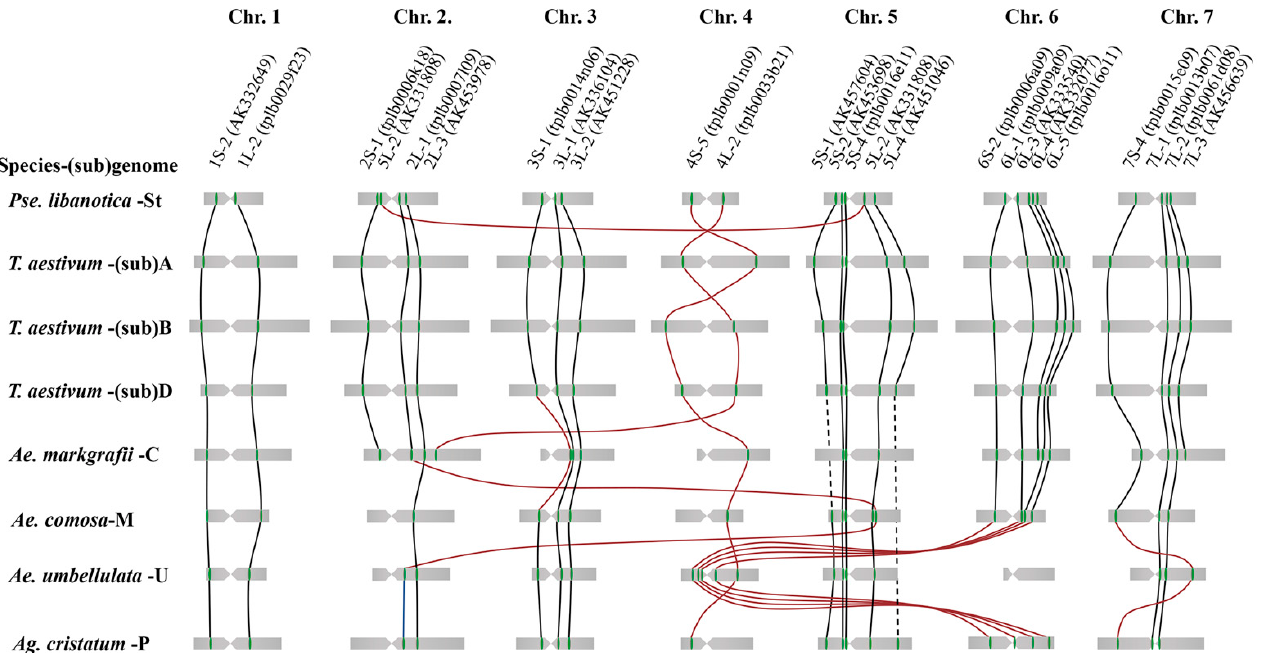
Figure 8. Cross-genome homoeologous within St genome of P. libanotica , A, B, and D sub-genome of T. aestivum , C genome of Ae. markgarii , M genome of Ae. comosa , U genome of Ae. umbellulate , and P genome of Ag. cristatum. Relatively chromosome length and gene position data of A, B, and D sub-genome of T. aestivum were prepared based on Chinese Spring reference genome (RefSeq v2.1) in the WheatOmics website (http://202.194.139.32/blast/blast.html, accessed on 2 November 2022) [35], C genome was generated from the publication of Danilova et al. [18], M, U, and P genomes were referred to by Said et al. [19,20]. The green dot on the chromosome indicates the cDNA sequence, and the red dot is a duplication of the original sequence. Black lines cross-genome indicate the collinearity and red lines present chromosome structure variation.